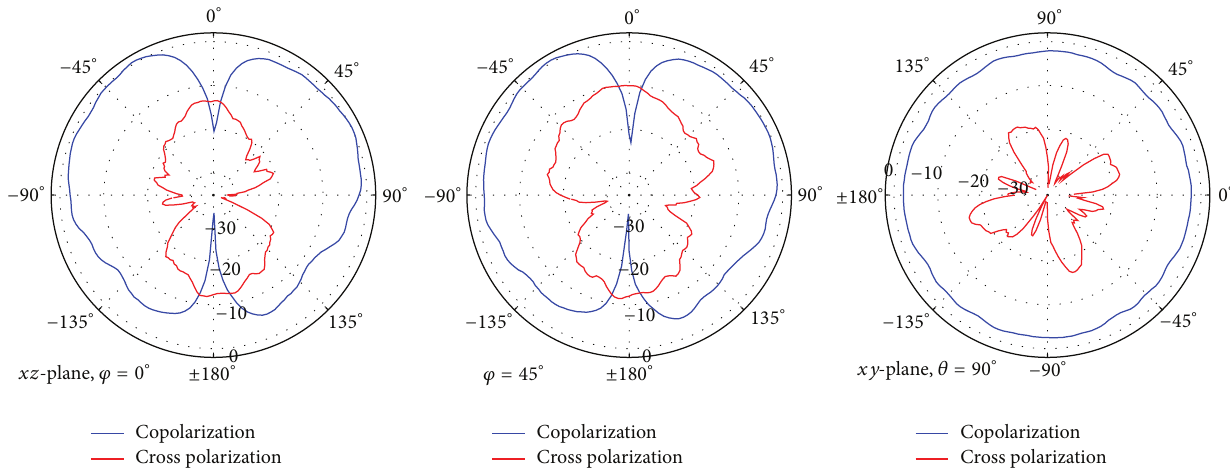
Figure 10: Measured realized gain pattern along the 𝑥𝑧 -plane, a plane inclined by 𝜑 = 45 ∘ , and the omnidirectional 𝑥𝑦